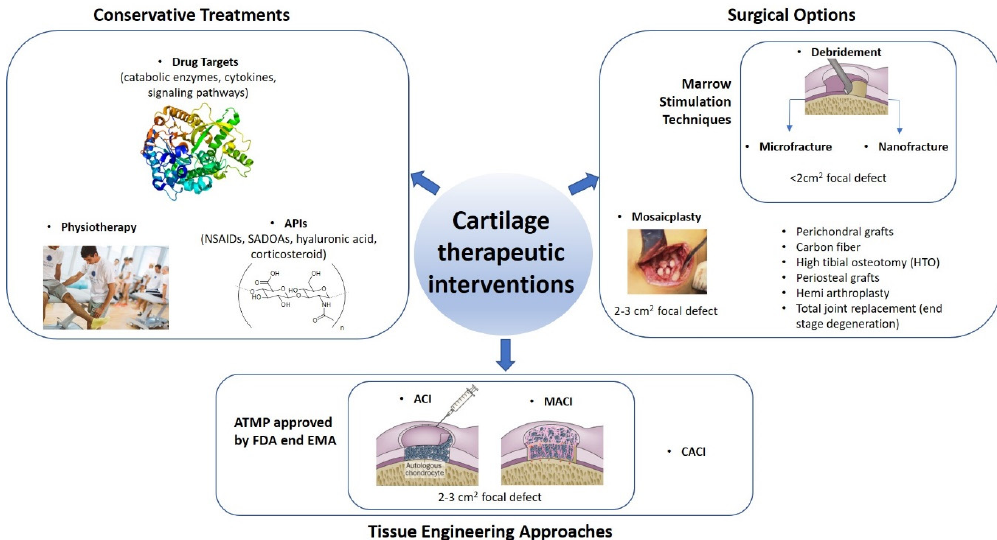
Figure 2. Therapeutic interventions to treat articular cartilage injuries of different size and severity. Defects with limited severity are treated by conservative treatments. Defects <2 cm 2 are treated with microfracture and nanofracture. Defects (2–3 cm 2 ) are treated with mosaicplasty, autologous chondrocyte implantation or matrix-assisted autologous chondrocyte implantation (ACI/MACI). Single or multiple larger (2–4 cm 2 ) defects are treated with grafts. End-stage osteoarthritic degeneration is treated by total joint replacement (TJR). Mosaicplasty photo is used under the terms of the Creative Commons Attribution-NonCommercial-No Derivatives License (CC BY NC ND). ACI, MACI and debridement pictures adapted by permission from Makris et al. 2015 [35]. Magnetic fields picture is reprinted with permission from Fini et al., 2005 [24]. Physiotherapy picture is licensed under the Creative Commons Attribution-Share Alike 4.0 International